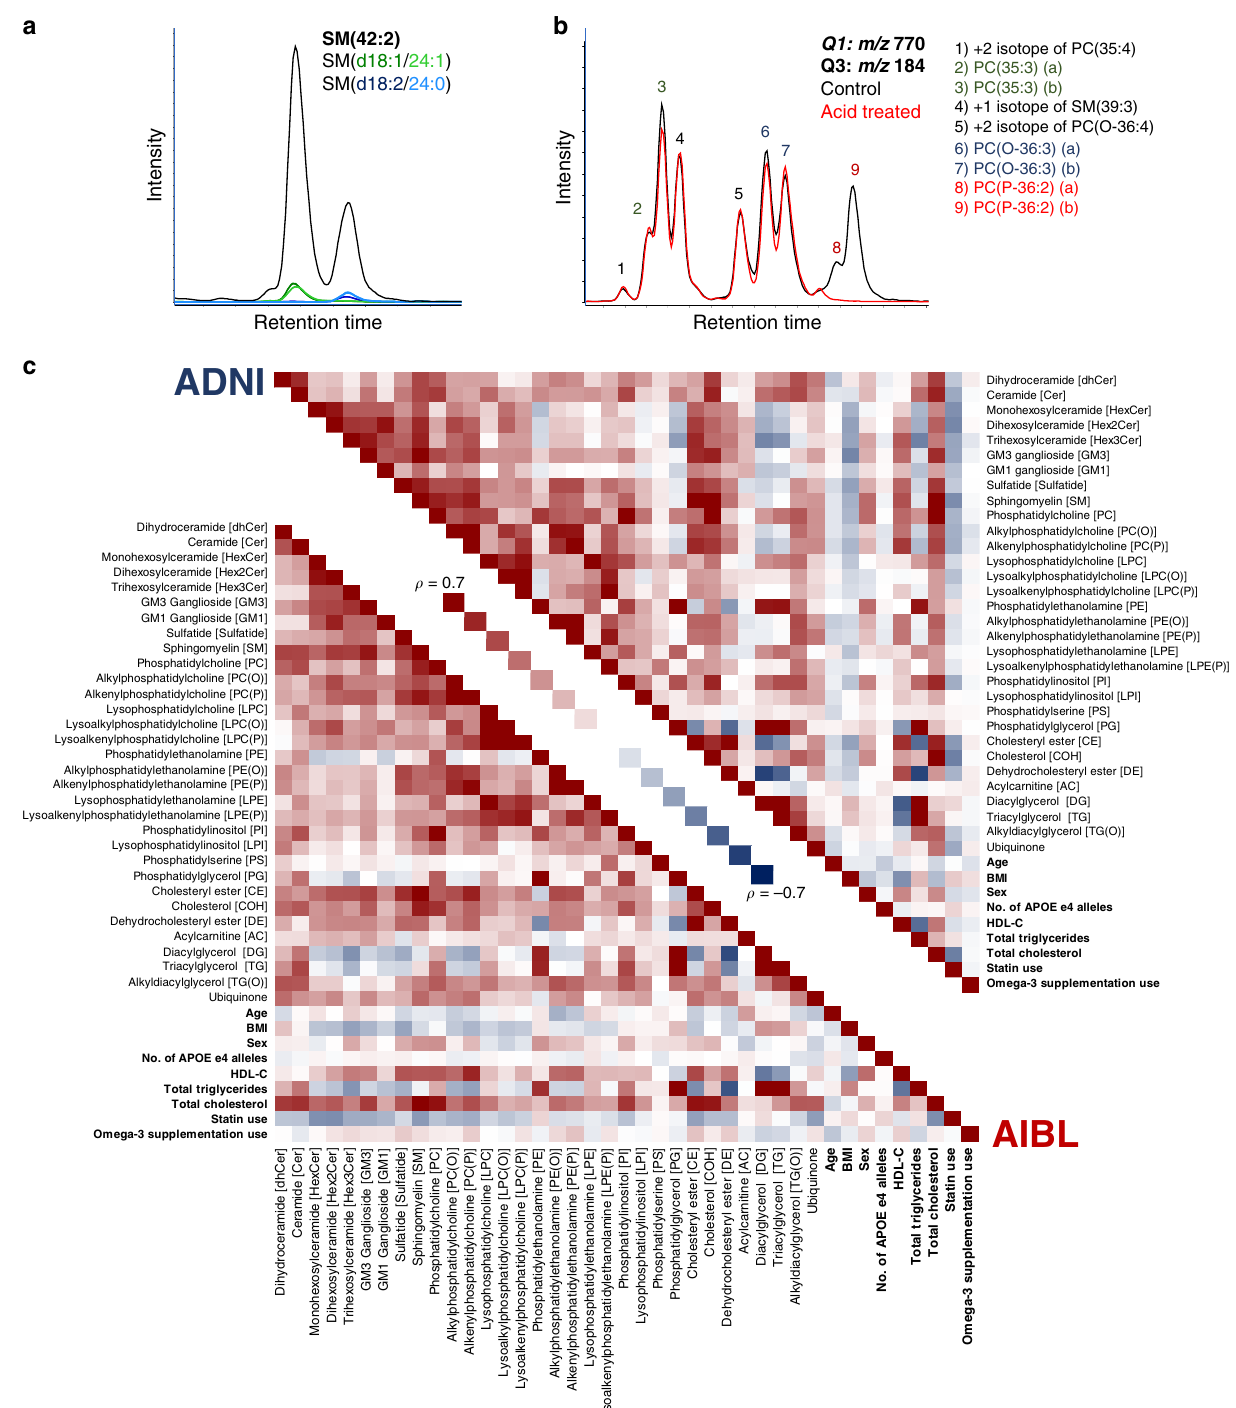
Fig. 1 Characterisation of lipid isomeric species and the relationship of lipid classes and subclasses within the AIBL and ADNI cohorts. a Characterisation of sphingomyelin isomers. Black trace corresponds to the chromatogram seen under normal conditions. Additional experimental results in the green and blue traces used for identi fi cation, corresponding to SM(d18:1/24:1) and SM(d18:2/24:0) respectively. b Characterisation of glycerophospholipid isomers. Black trace corresponds to the chromatogram seen under normal conditions. Red trace is the same scan after sample acid hydrolysis. c Spearman correlation of total lipid classes, subclasses and commonly reported clinical measures (bolded) for the AIBL baseline and ADNI